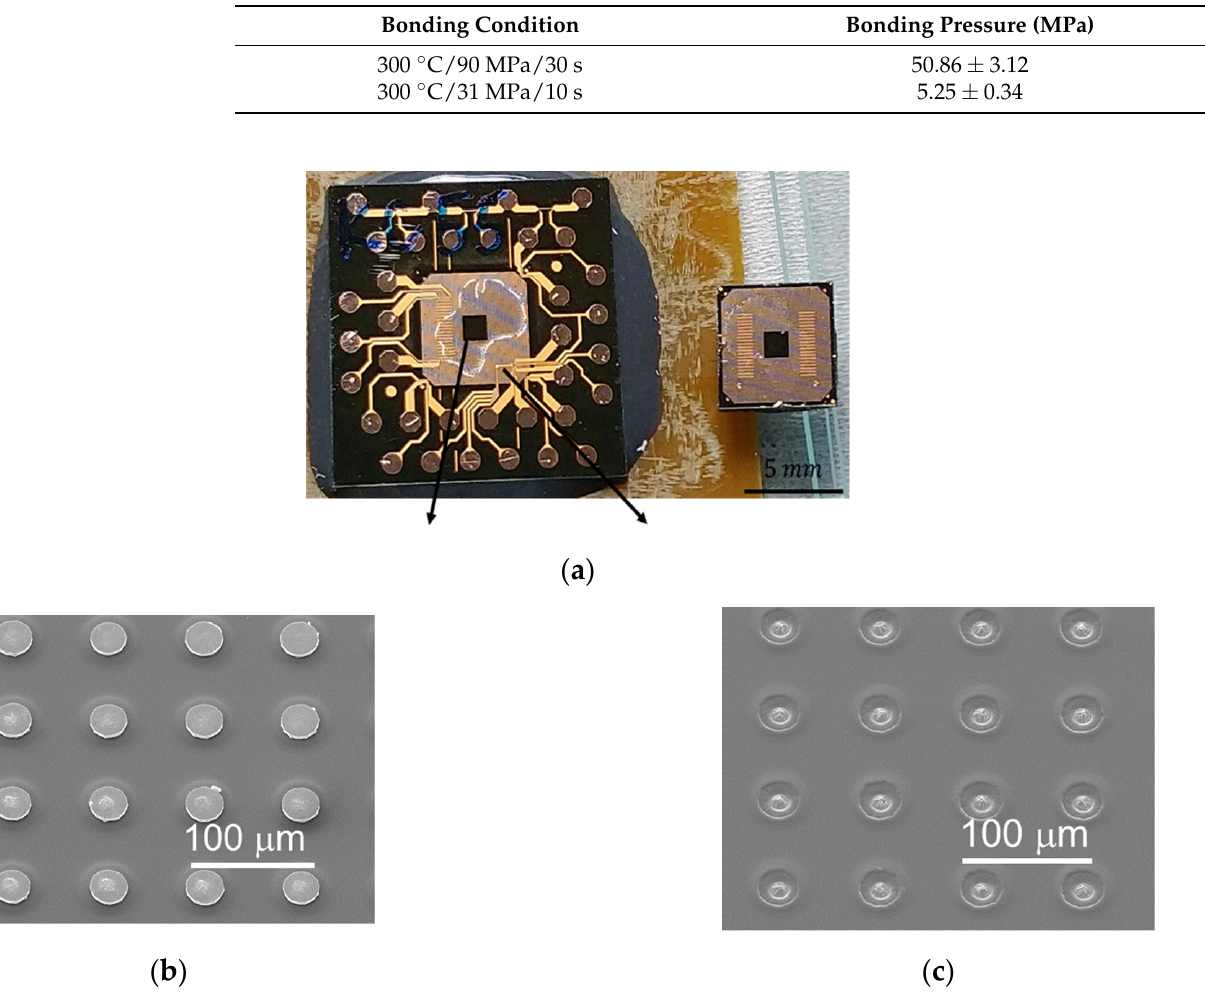
Figure 10. ( a ) The images of the chip after tensile test. The bonding condition is 300 ◦ C/90 MPa/30 s. Two kinds of fracture modes are observed. ( b ) At the center area, fracture tended to form at the bonding interface. ( c ) At the edge of the bump array, fracture occurred at PSV openings.